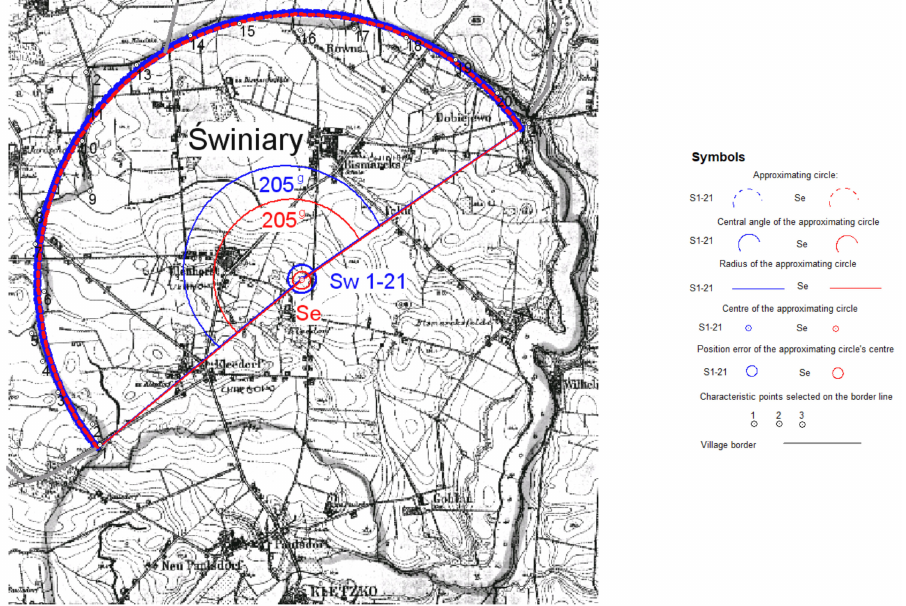
Figure 14. ´Swiniary. Course, position and error of the approximating circle: Sw 1—21— approximation of points 1—21, Se—approximation of points 1—21, without points 9, 12.